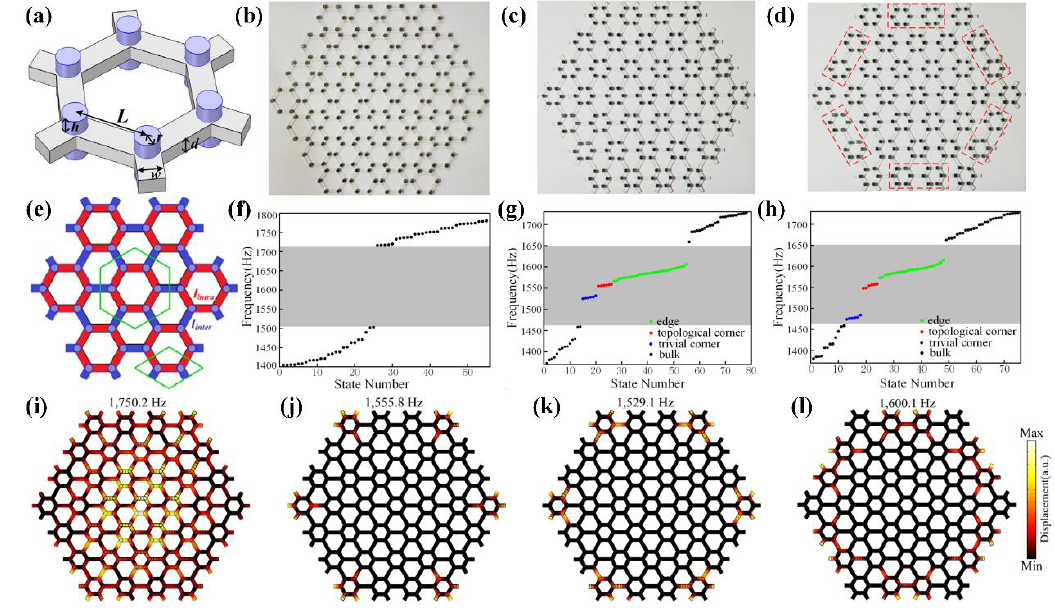
Figure 5. Elastic hexagon-shaped Tis [106]. ( a ) A composite unit cell of the hexagonal lattice. ( b – d ) Hexagon-shaped structures consisting of expanded unit cells ( b ), shrunken unit cells ( c ) and shrunken unit cells with defects ( d ), respectively. The defects are realized through adding a magnet on six nodes, respectively, at the upper side of 12 composite unit cells (marked by the red dashed box). ( e ) The schematic of the honeycomb lattice model. The red (blue) beams whose lengths are denoted by l intra < l inter representing the intracell (intercell) hoppings. ( f – h ) The schematics of the simulated state number responding to ( b – d ), respectively. ( i – l ) The simulated modes of bulk state at 1750.2 Hz ( i ), topological corner state at 1555.8 Hz ( j ), trivial corner state at 1529.1 Hz ( k ) and gapped edge state at 1600.1 Hz ( l ).